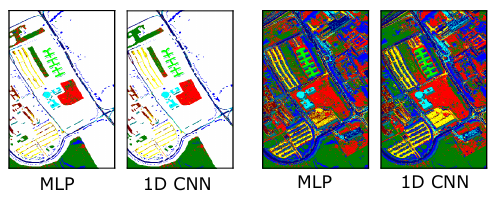
Figure 5. 1D-CNN and MLP classification results